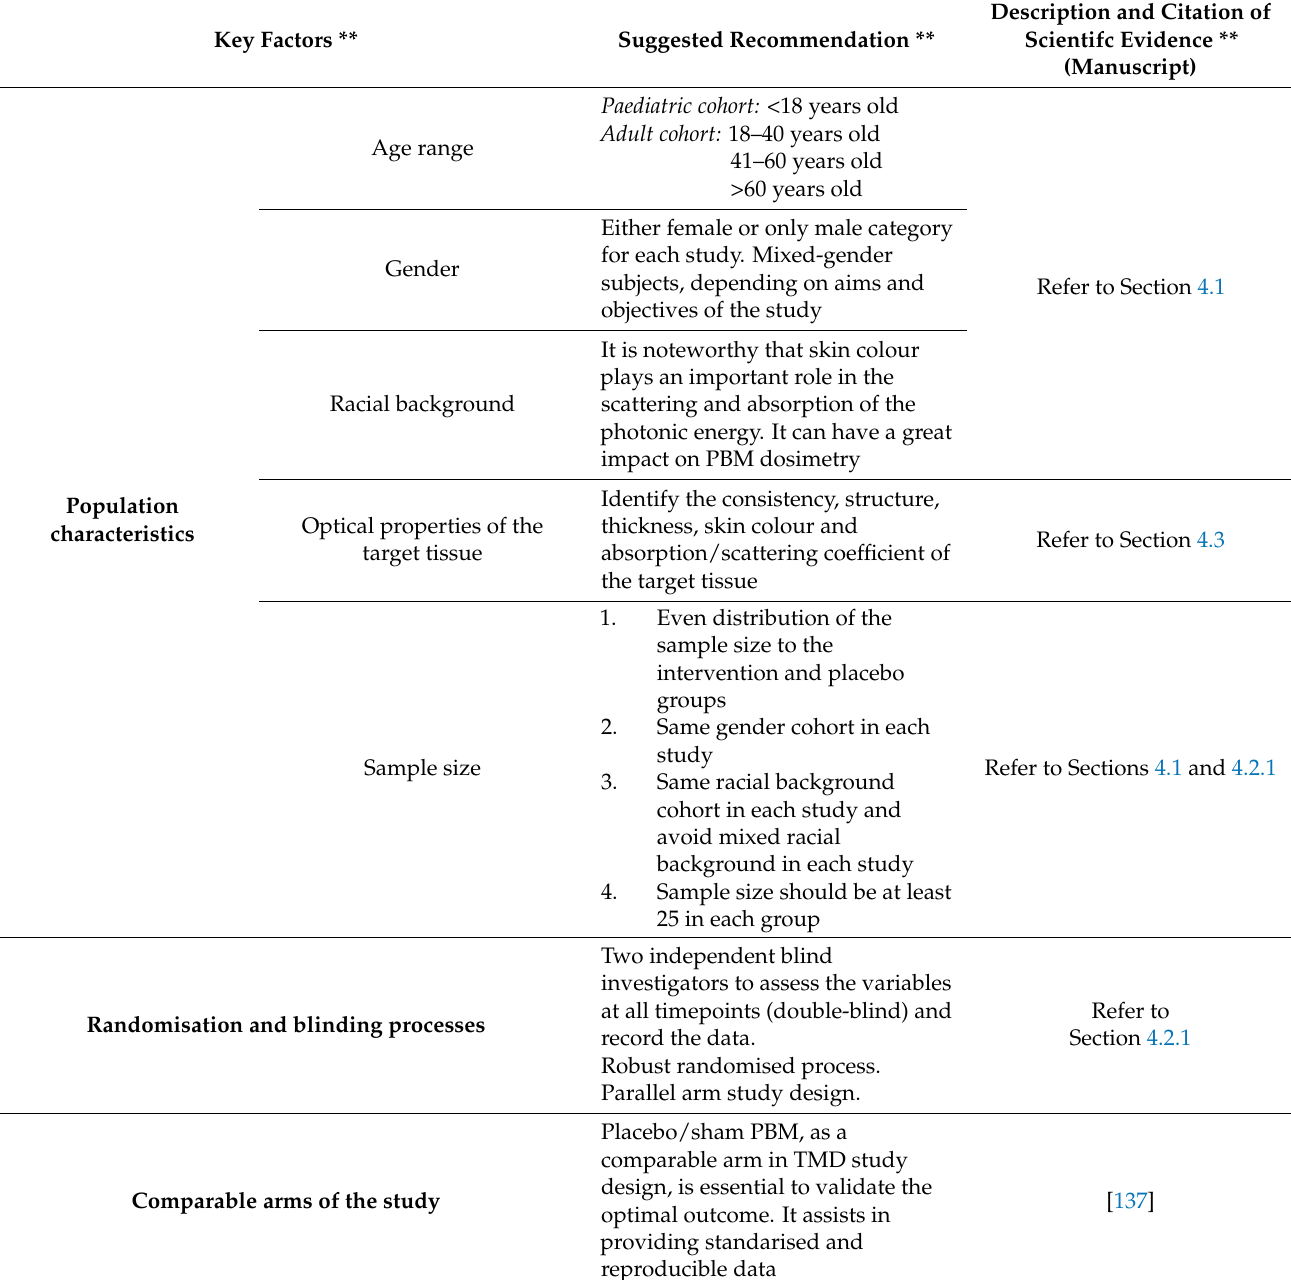
Table 4. Illustrates summary of the key factors that are important in TMD study design and suggested recommendations for reproducible methodology, intending only to provide clinical guidance and serve as a starting point for extensive research. ** All the abbreviations in this table are listed in Supplementary File